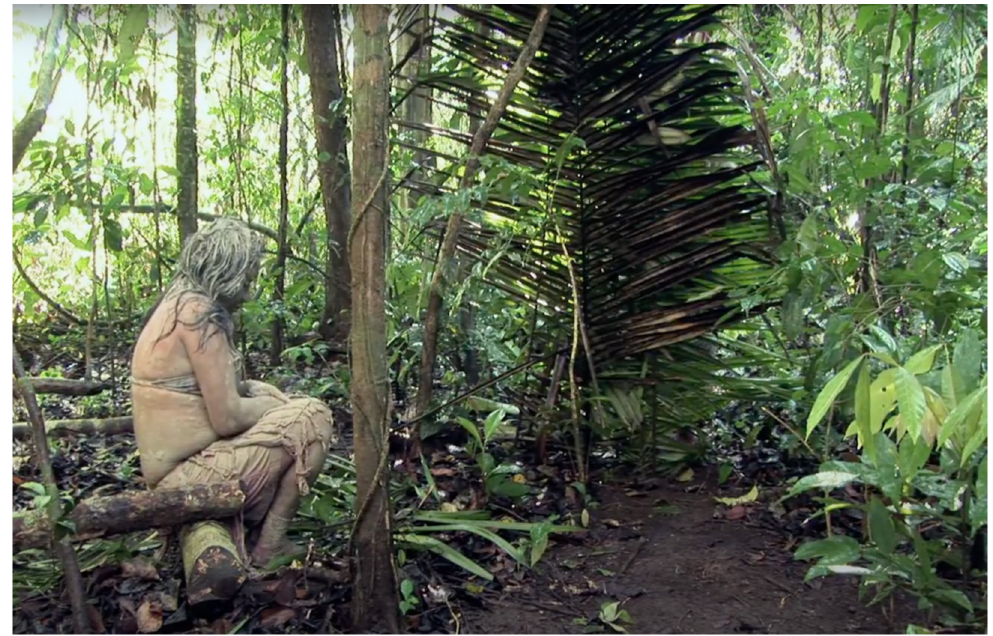
Figure 2. Still from Shuku Shukuwe .